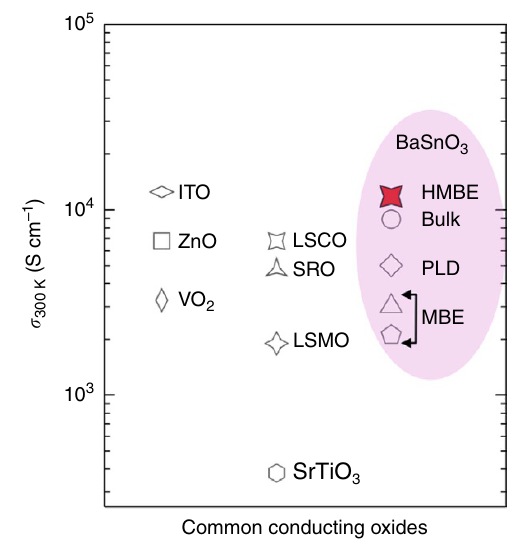
Figure 6 | Comparison of conductivity values for common conducting oxides. Compilation of highest room temperature conductivity s 300K of BaSnO 3 bulk single crystal and films grown by various deposition techniques (taken from refs 9,16,22) including hybrid molecular beam epitaxy. The highest known s 300K for common transparent conducting oxides (ITO ¼ indium tin oxide, ZnO) and other metallic oxides as conductive electrodes for high frequency applications (VO 2 ,